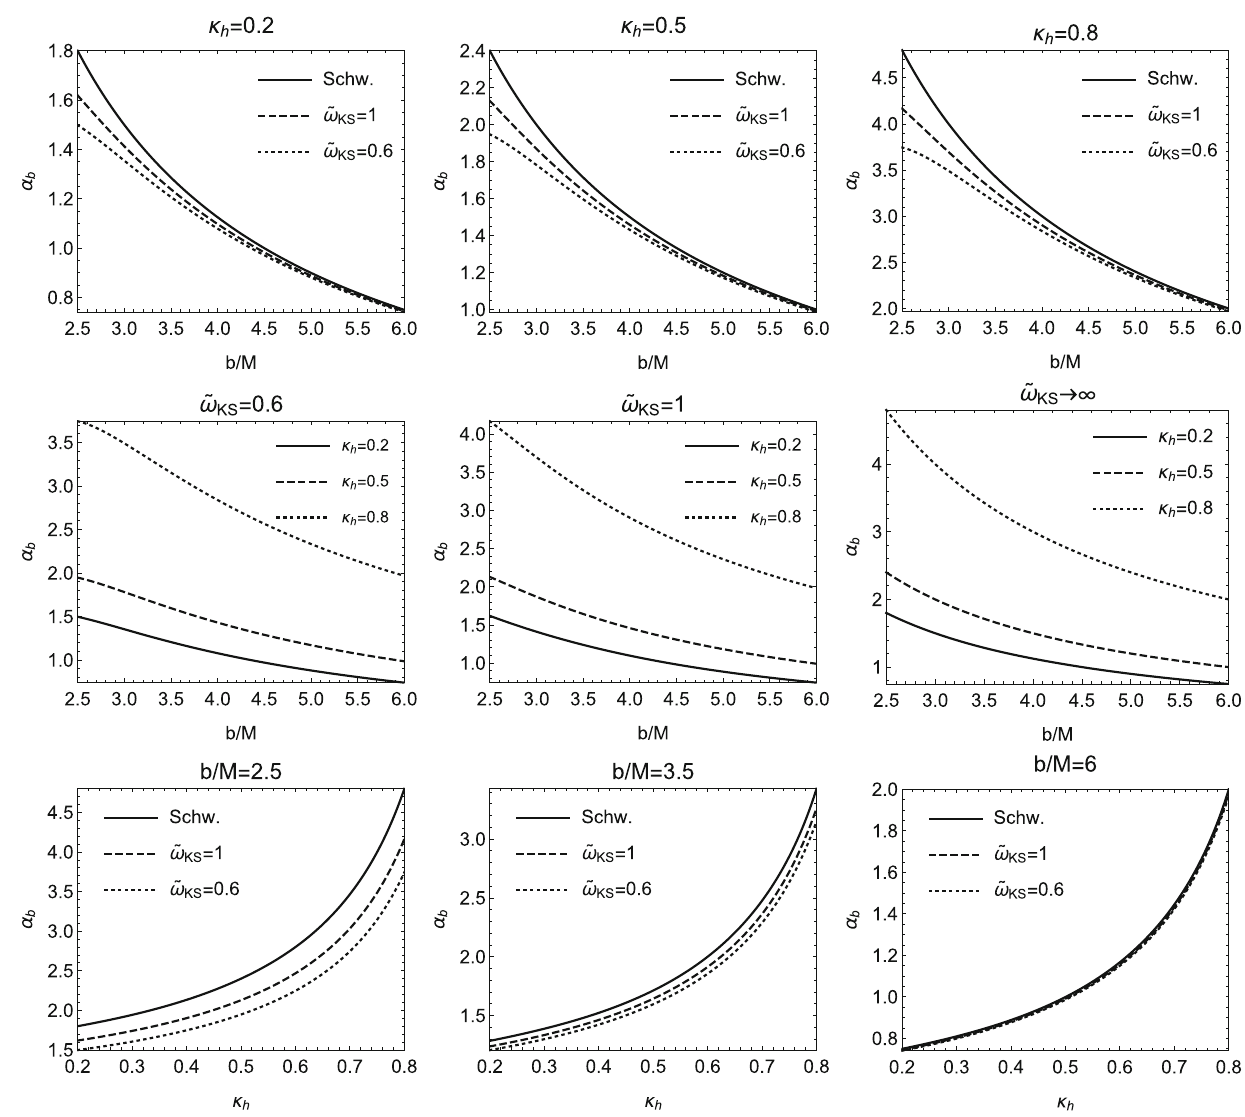
of the deflection angle of photon with plasma parameter for various combinations of dimensionless “Hoˇrava parameter” ( ˜ ω sionless impact parameter ( b / M